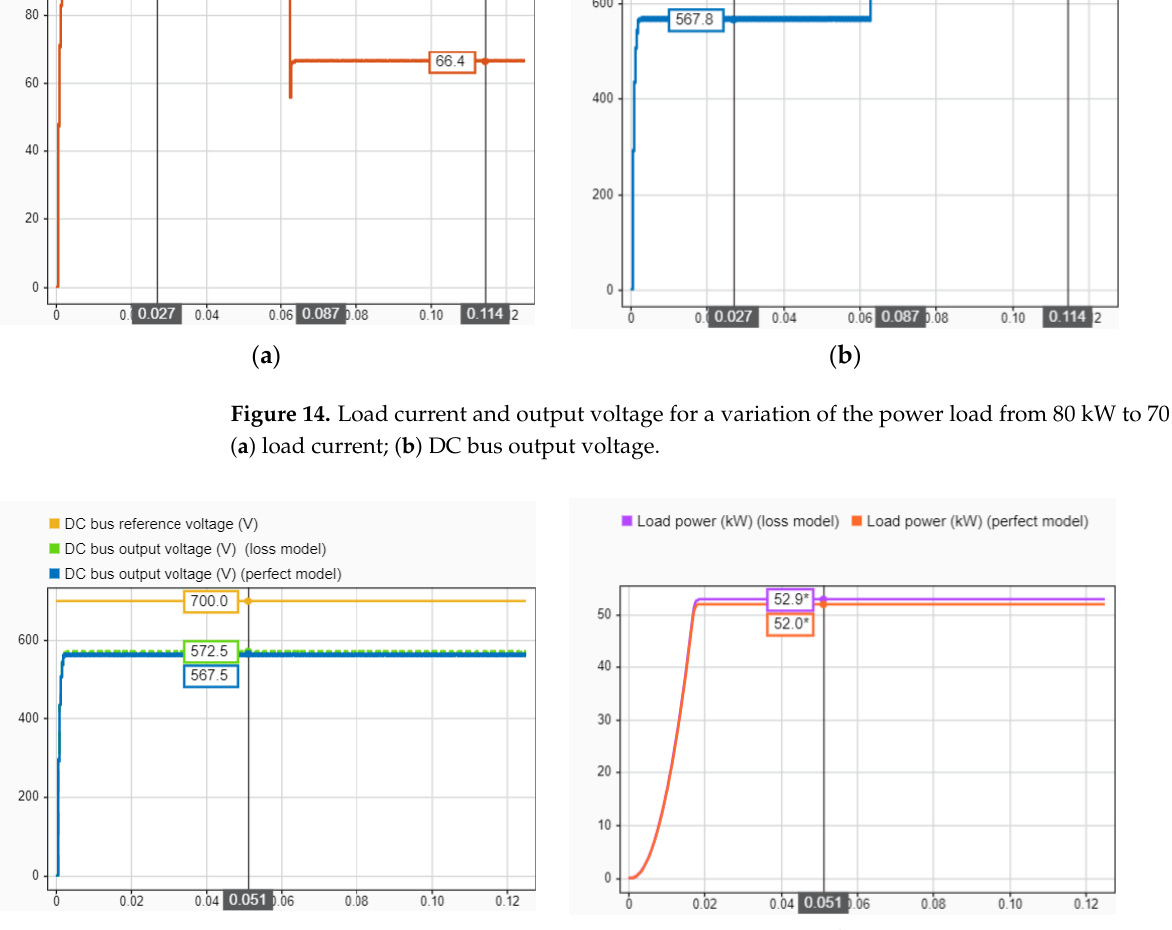
Figure 15. Output voltage and load power for 80 kW using perfect model and conduction loss model for DAB DC-DC converter: ( a ) DC bus output voltage; ( b ) load power.